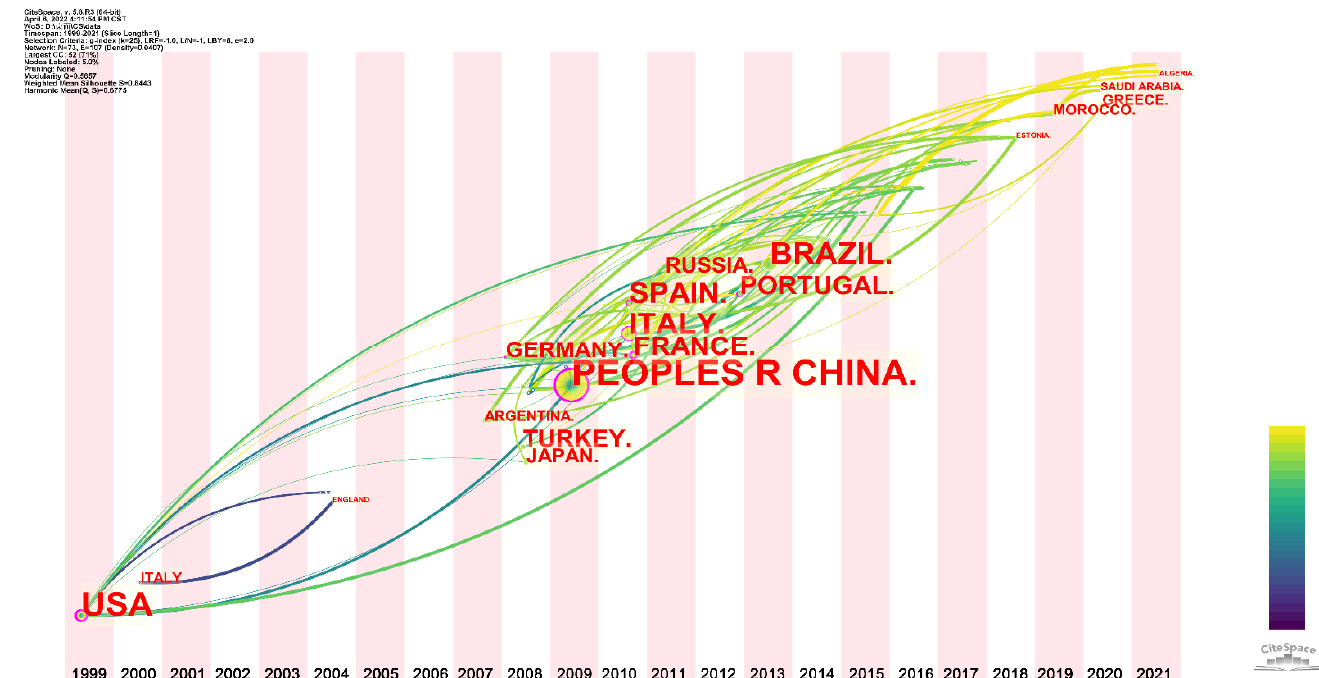
Figure 6. Time-zone view of geographic distribution for the evaluation of antioxidants using electro- chemical